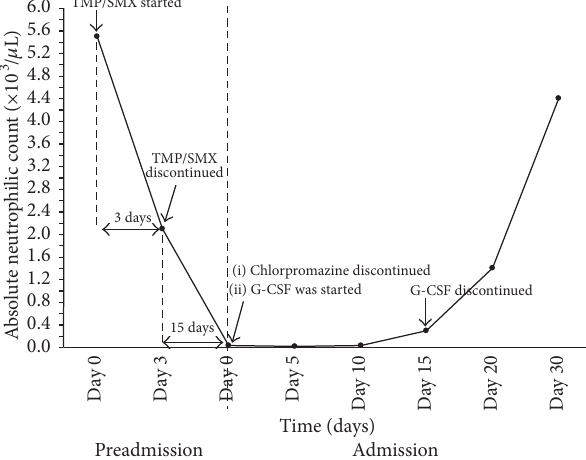
Figure 1: Timeline of absolute neutrophilic count